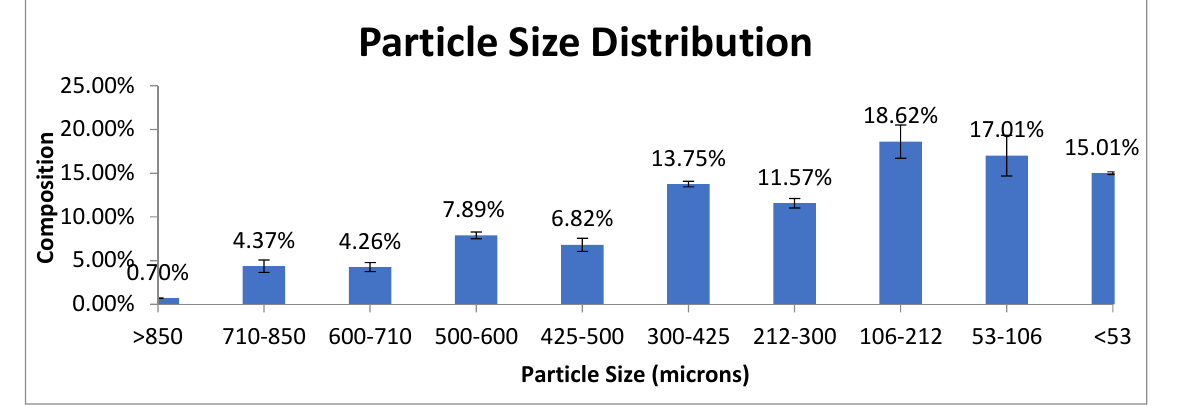
Figure 1. The particle size of the natural zeolite.